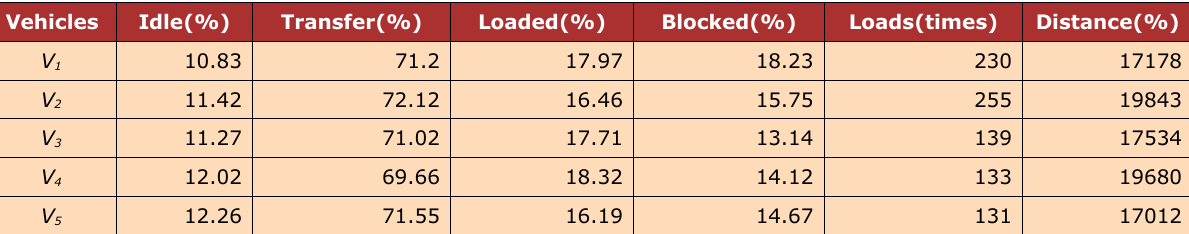
Table 8. The simulation results after the optimization of step two